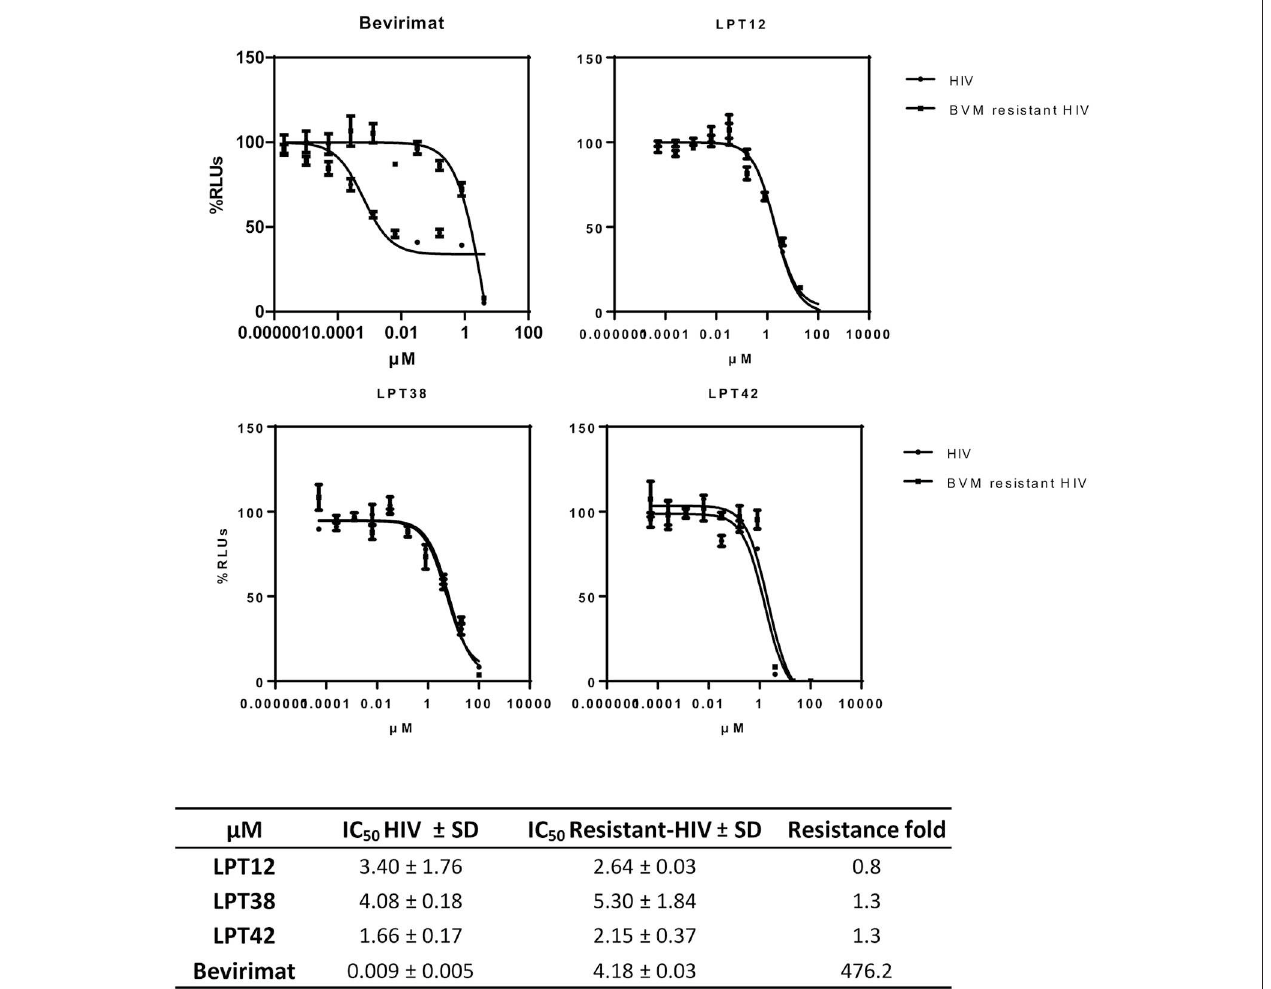
FIGURE 9 | Effect of LPTs on MT-2 infection with a bevirimat-resistant HIV-1 BVM resistant HIV) as compared to the wild type virus ( HIV). Results are shown as percentage of RLUs as compared to an untreated control. IC 50 values were calculated with GraphPad Prism software, using non-linear regression analysis (Log inhibitor vs. response). SD, Standard